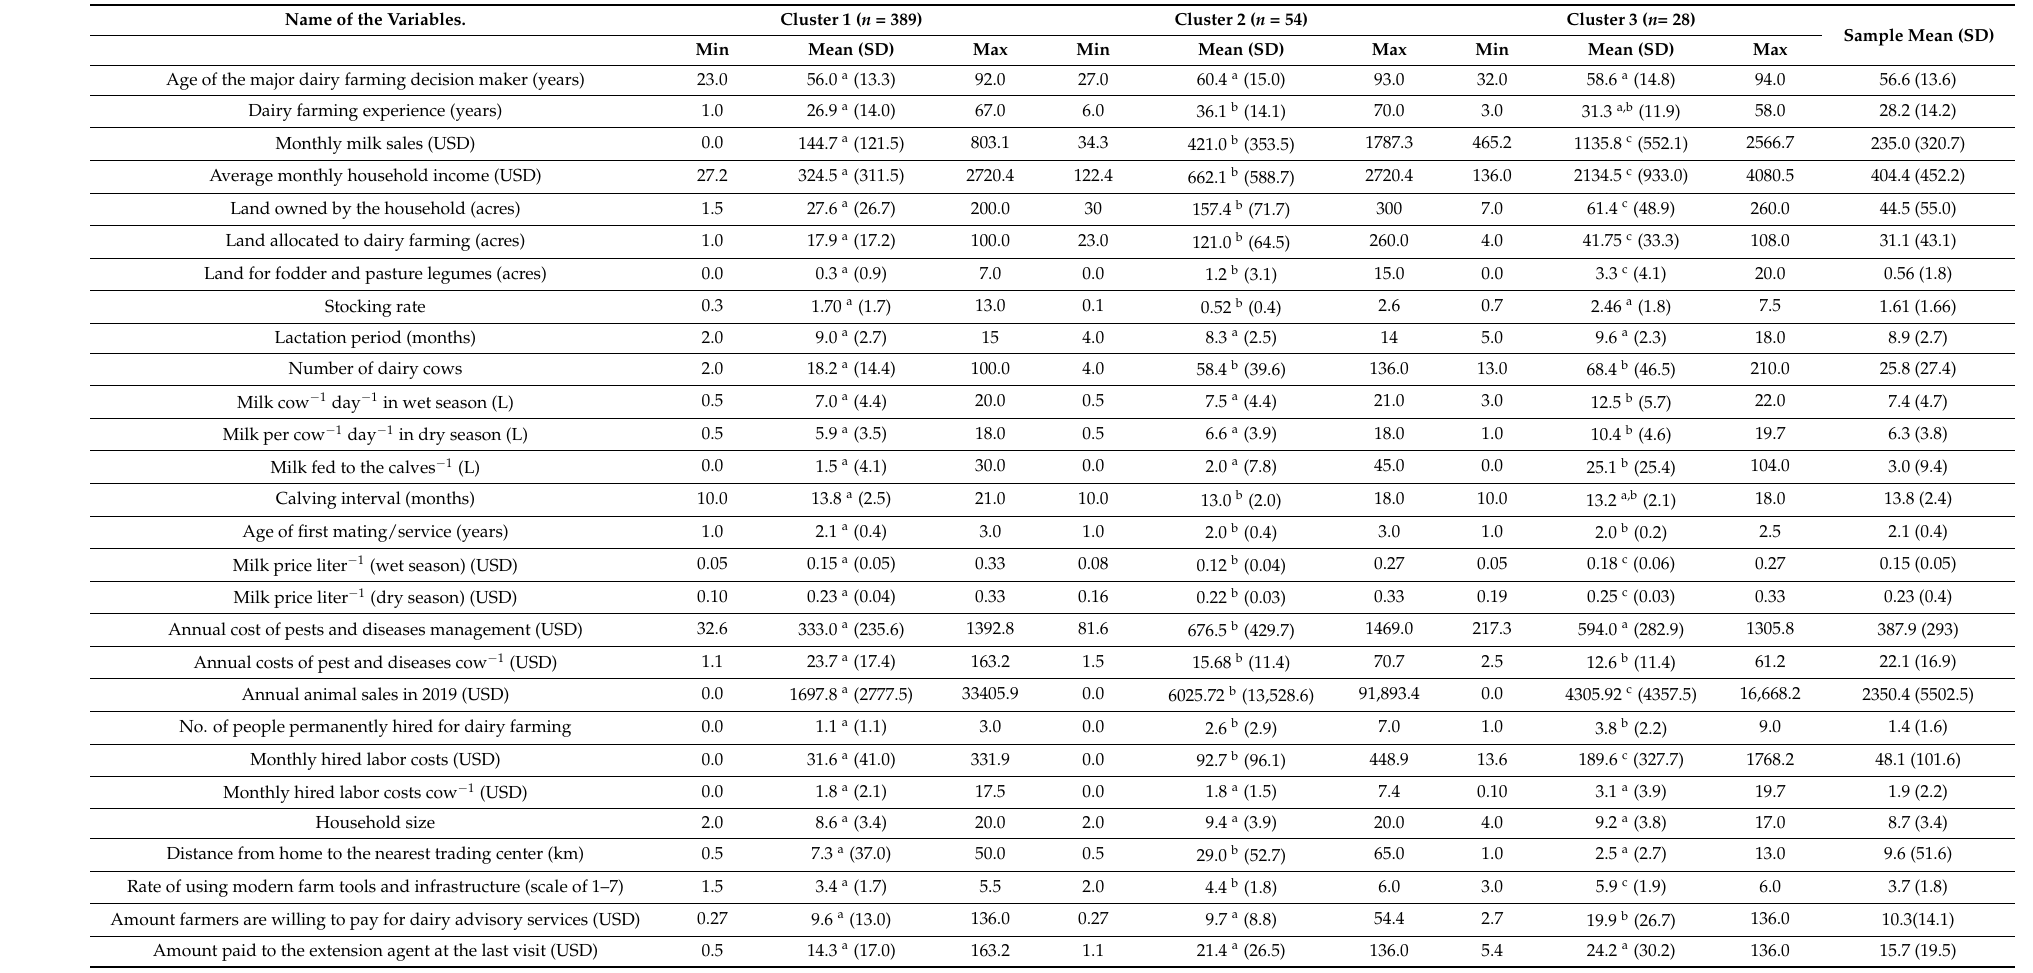
Table 7. Quantitative variables that characterize the dairy cattle production